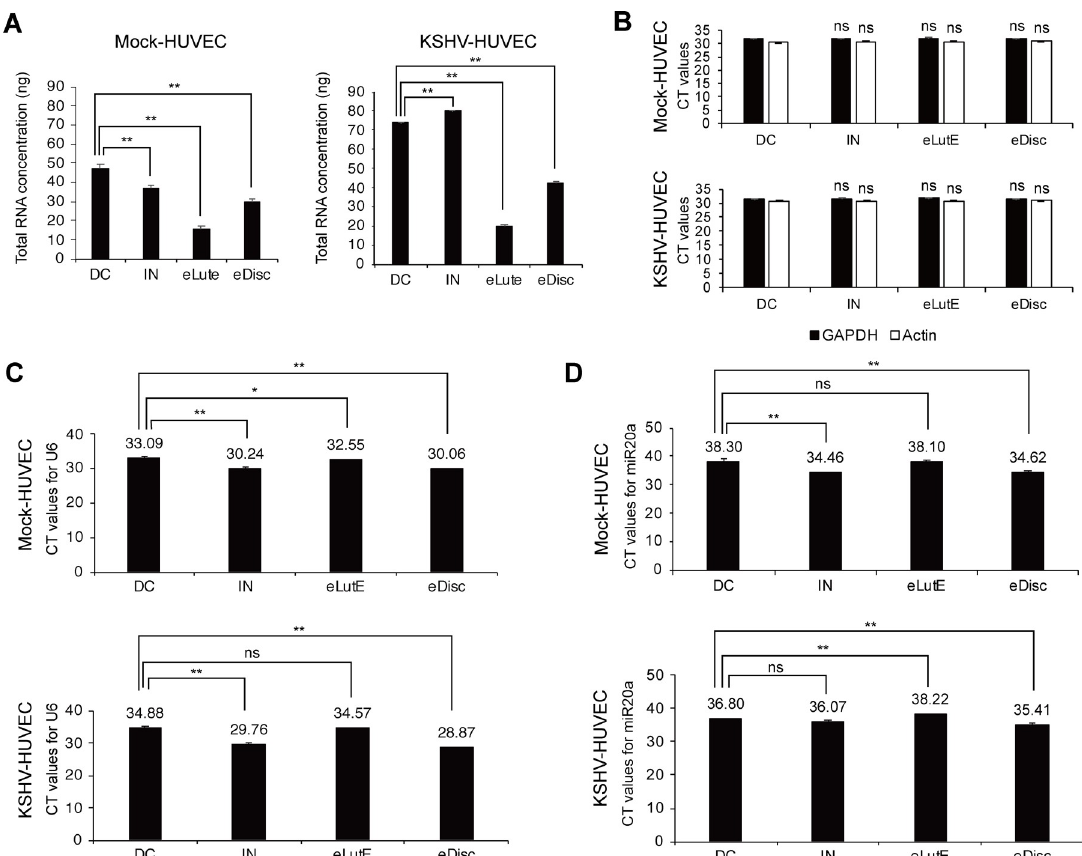
Fig 3. Analysis of RNA from EVs separated using each method. (A) Quantification of EV RNA separated using the four different methods. The total quantity of RNA was calculated according to the concentration measured using Nanodrop and is presented based on the EVs separated from 1 mL of culture supernatant. DC: EVs separated using differential centrifugation. IN: EVs separated using the Invitrogen Total Exosome Isolation reagent. eLutE: EVs separated using the ExoLutE exosome isolation kit. eDisc: EVs separated using Exodisc from LabSpinner. Data are shown as the mean ± SD, n = 3, �� p < 0.01. (B) qRT-PCR of GAPDH and β -actin with equal amounts of RNA from the EVs separated by each method. The number above the bar graph indicates the average CT value from the qRT-PCR reaction. CT values from differential centrifugation were used as a control. Data are shown as the mean ± SD, n = 3, ns: not significant. (C and D) qRT-PCR for U6 snRNA (C) and miRNA20a (D) with equal amounts of RNA from the EVs separated by each method. The number above the bar graph indicates the average CT value from the RT-qPCR reaction. Mock-HUVEC: mock-infected HUVECs. KSHV-HUVEC: KSHV-infected HUVECs. Data are shown as the mean ± SD, n = 3, � p < 0.05, �� p < 0.01, ns: not